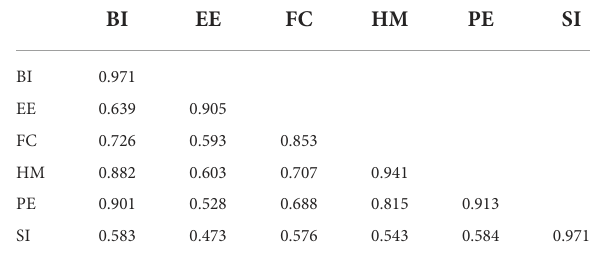
TABLE 6 Fornell-Larcker criterion table.